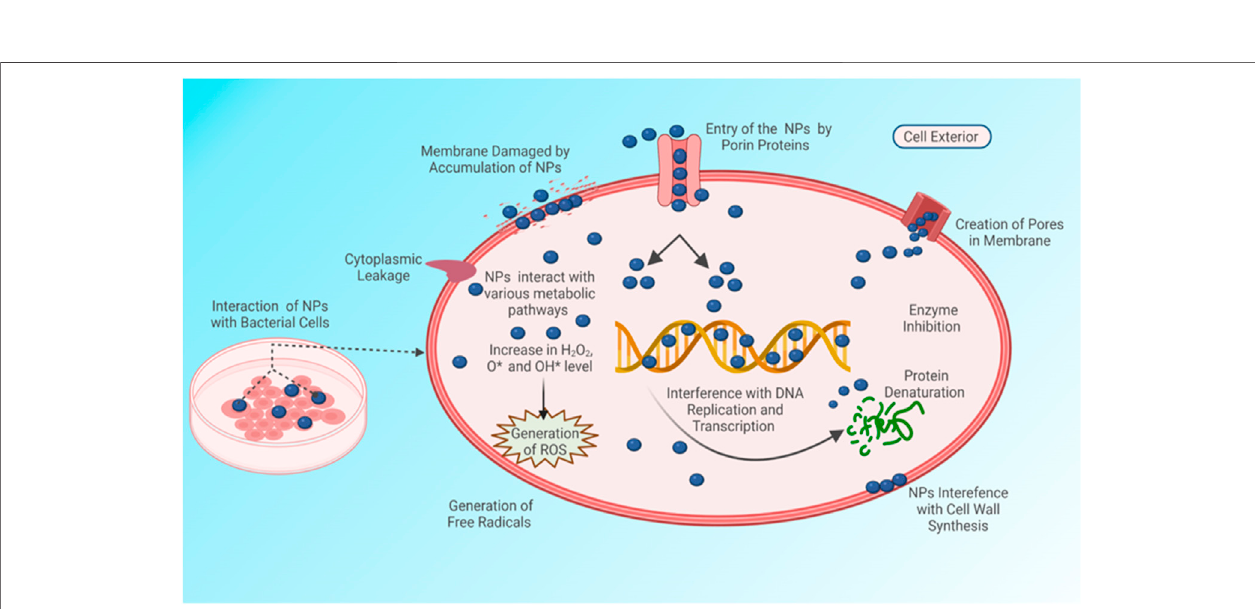
FIGURE 12 | Antibacterial mechanisms of ZnO